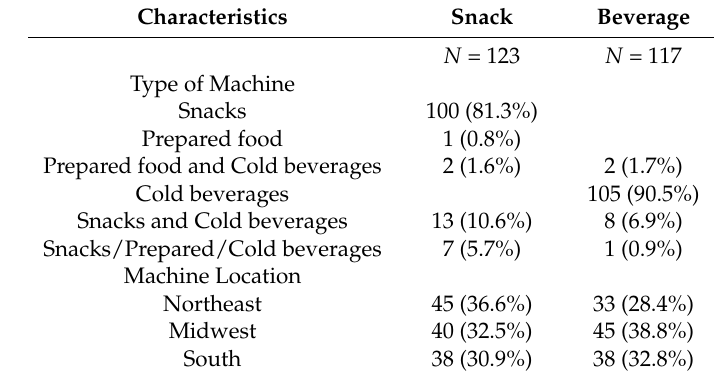
Table 3. Characteristics of machines audited.